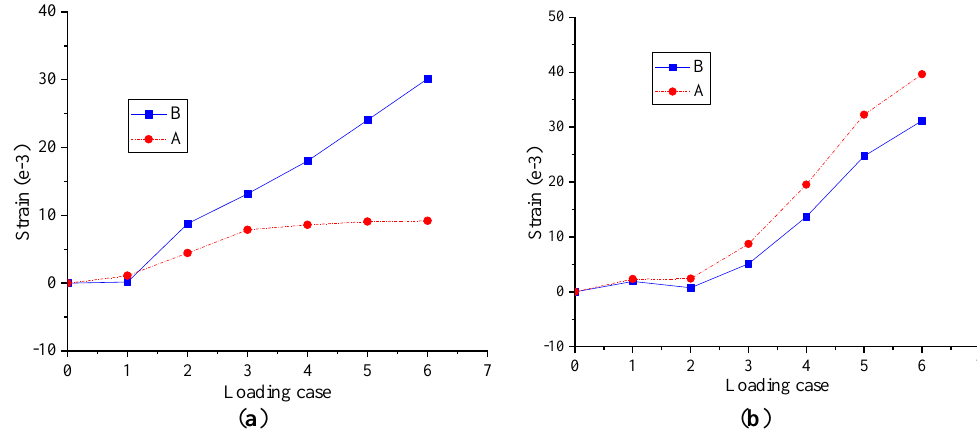
Figure 6. Strain curves. ( a ) Maximum normal strain at back surface of the impact position; and ( b ) maximum shear strain at the corresponding side plate of the impact position.